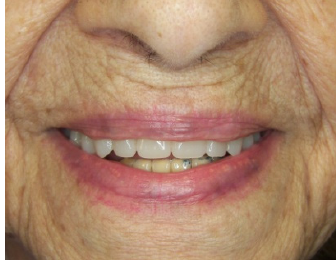
Figure 23. The patient wearing her new CD.